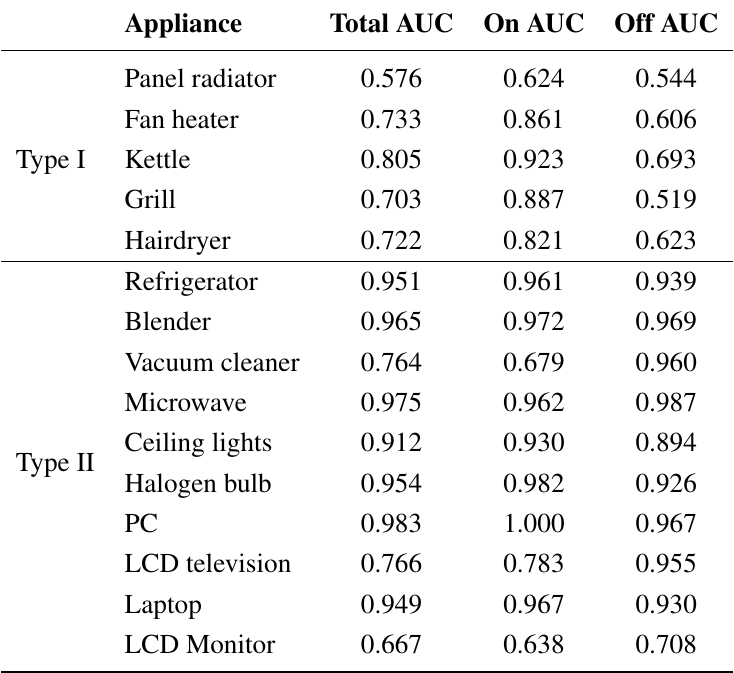
Table 10. AUC calculated for identifying an appliance turning ON and OFF when classifying the type based on the transient signal and then using a select set of current harmonics as features based on the